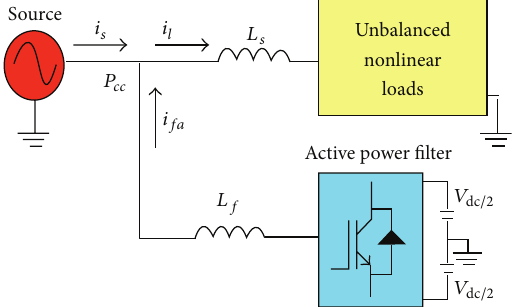
Figure 1: Shunt active filter under unbalanced nonlinear load.